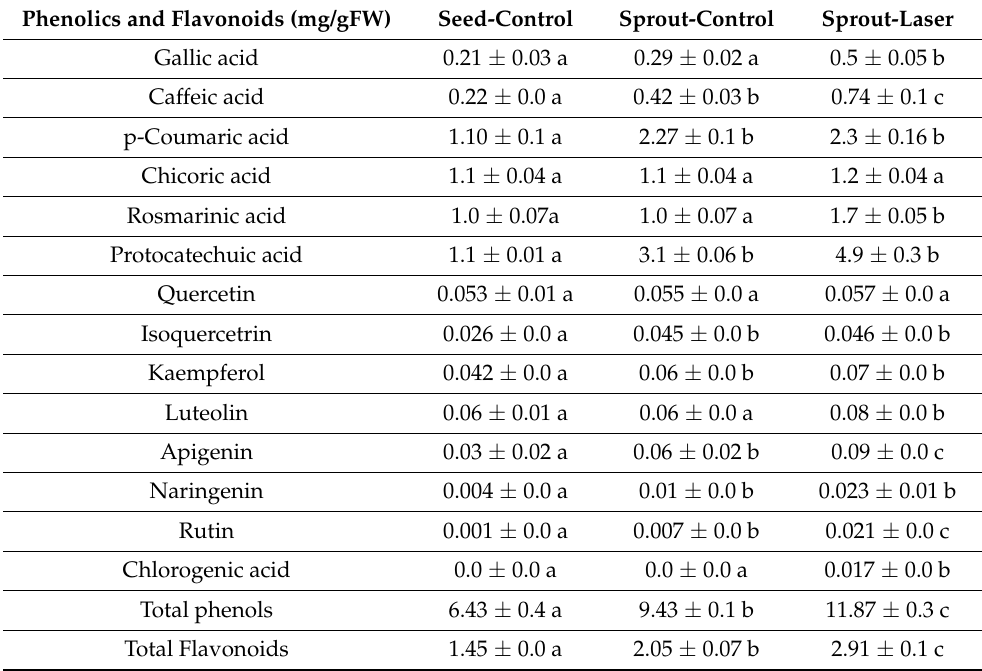
Table 5. Effect of He-Ne laser light treatment on phenolic and flavonoid contents of Cymbopogon proximus sprouts and seeds. Data are represented by means ± standard errors. Phenolics and Flavonoids